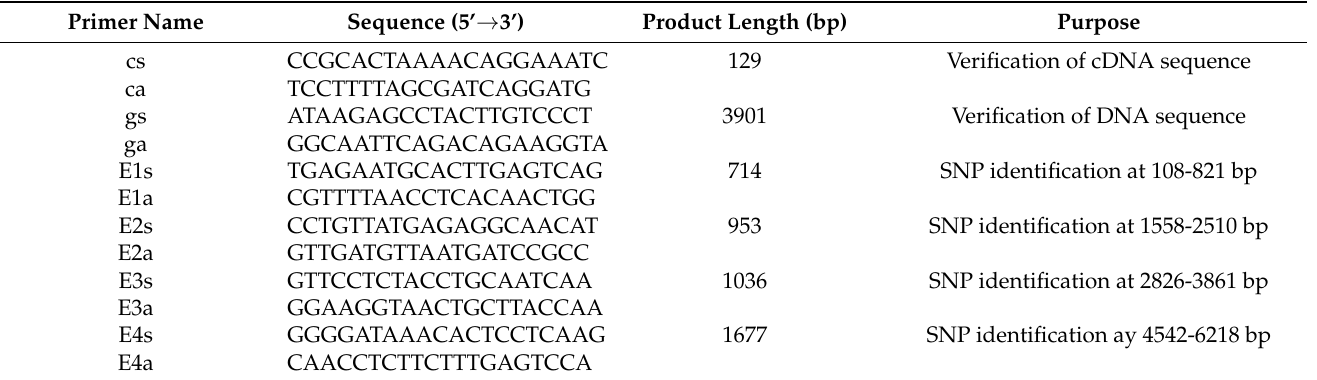
Table 1. Primers used in this